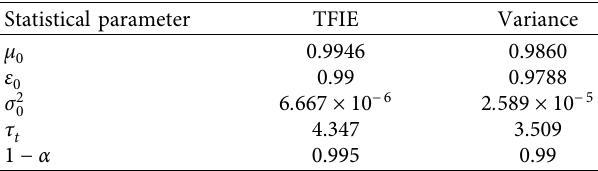
Table 2: Hypothesis test of the proposed TFIE feature and the variance feature on the generated dataset.